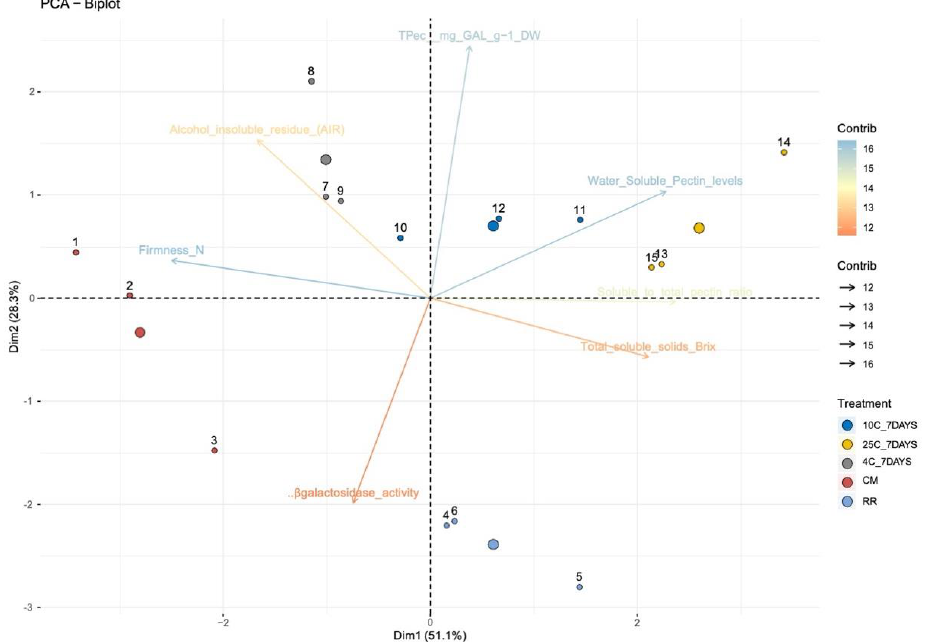
Figure 2. Biplot Principal coordinate analysis across stages. Larger dots indicate mean values calculated from discrete biological replications. The contribution of each trait in the two dimensions is indicated by a gradient scale and color intensity (scale). Vectors near the plot center have lower cos2 values. Narrow angles among variables indicate affinity and wide angles a negative correlation.